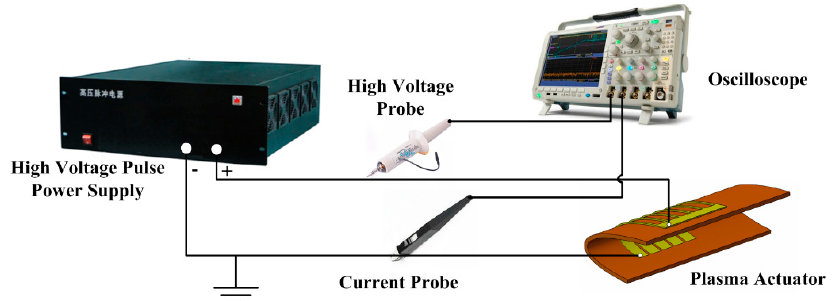
Figure 4. Schematic illustration of NS-DBD plasma actuator.